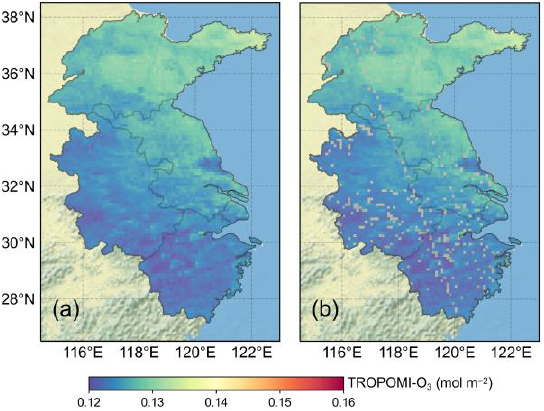
Figure 3. Comparisons of the five imputed methods for in situ missing observations.